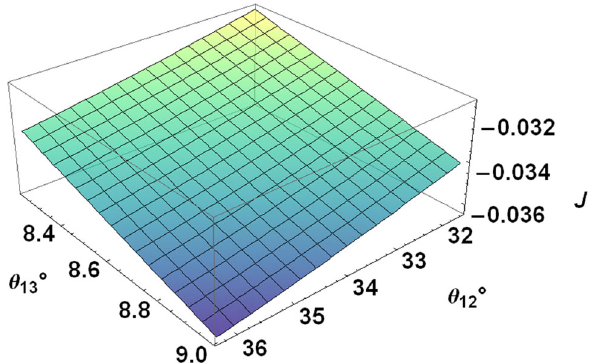
Fig. 3 TheJarlskoginvariant J forneutrinosintheframeworkofCBM parameterization as a function of the mixing angles θ 12 , , θ 13 ( δ CP = 270 ◦ )